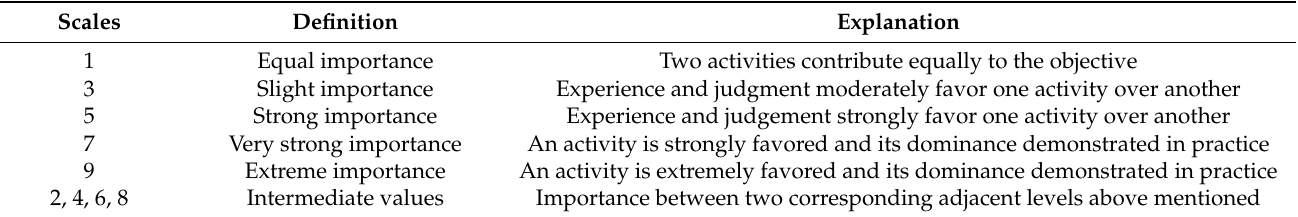
Table 5. Scales of pairwise comparison.